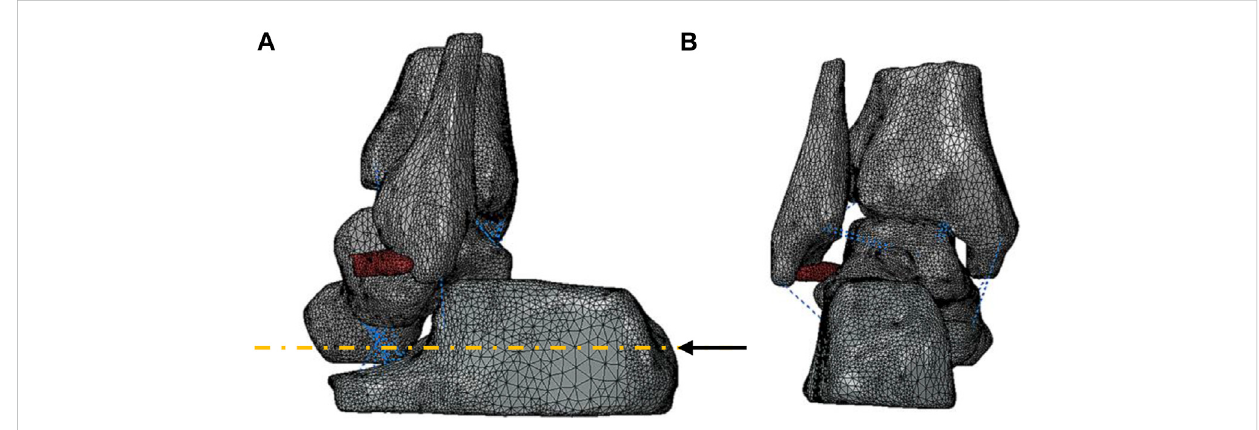
FIGURE 1 Three-dimensional geometry model of the ankle joint: (A) lateral view and (B) posterior view of the bones and ATFL represented in grey and red, respectively. A black arrow represented the vector of the forward force. The blue dotted lines showed the eight ligaments established in 1D truss elements.